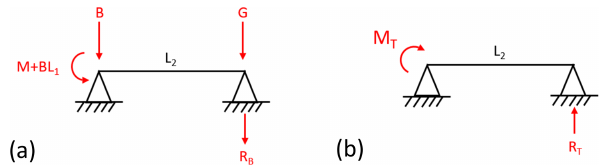
Figure 12. (a) Force balance corresponding to deflection model 1. (b) Force balance corresponding to deflection model